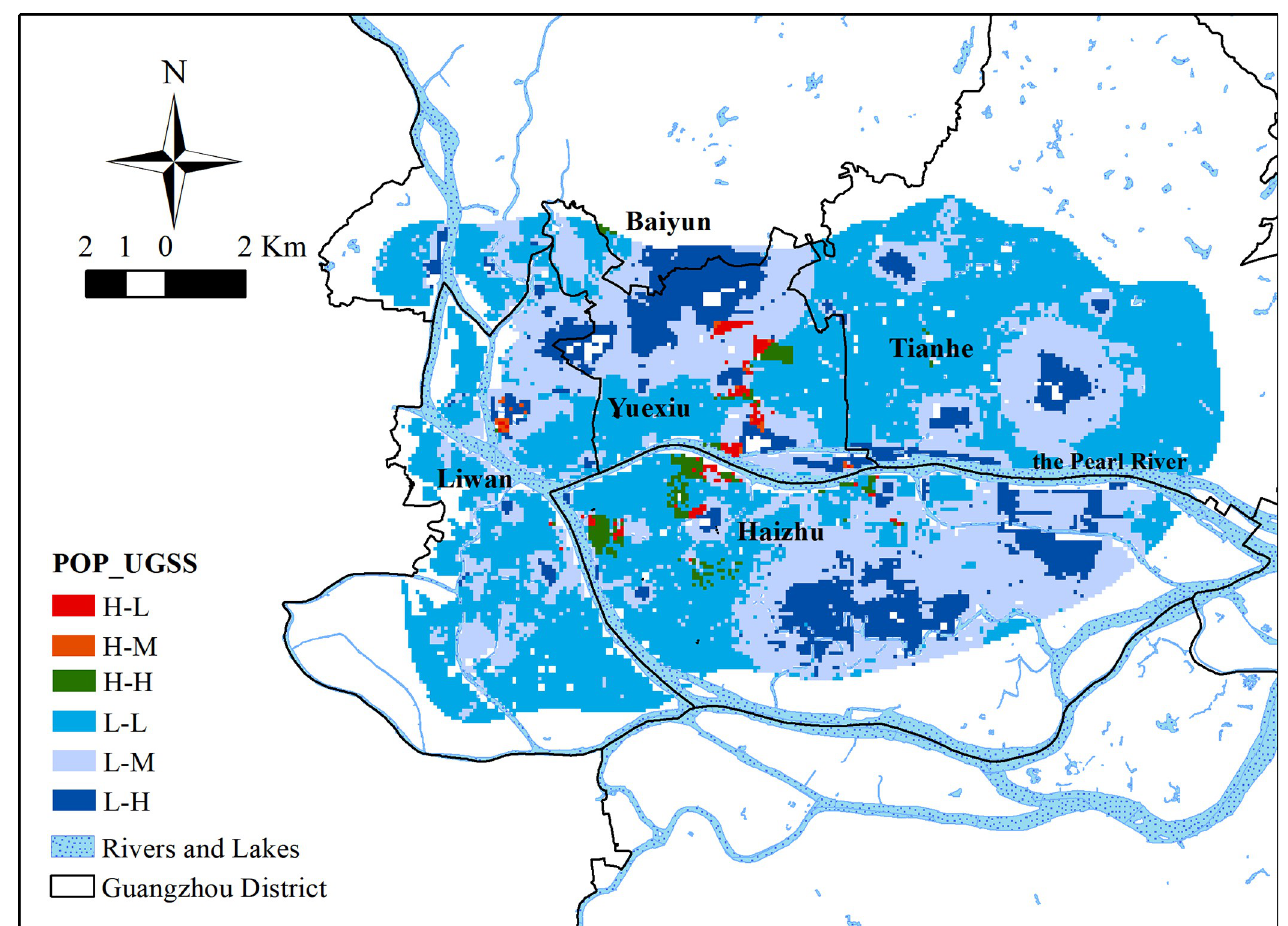
Fig 9. The Spatial distribution of the UGSS service efficiency.